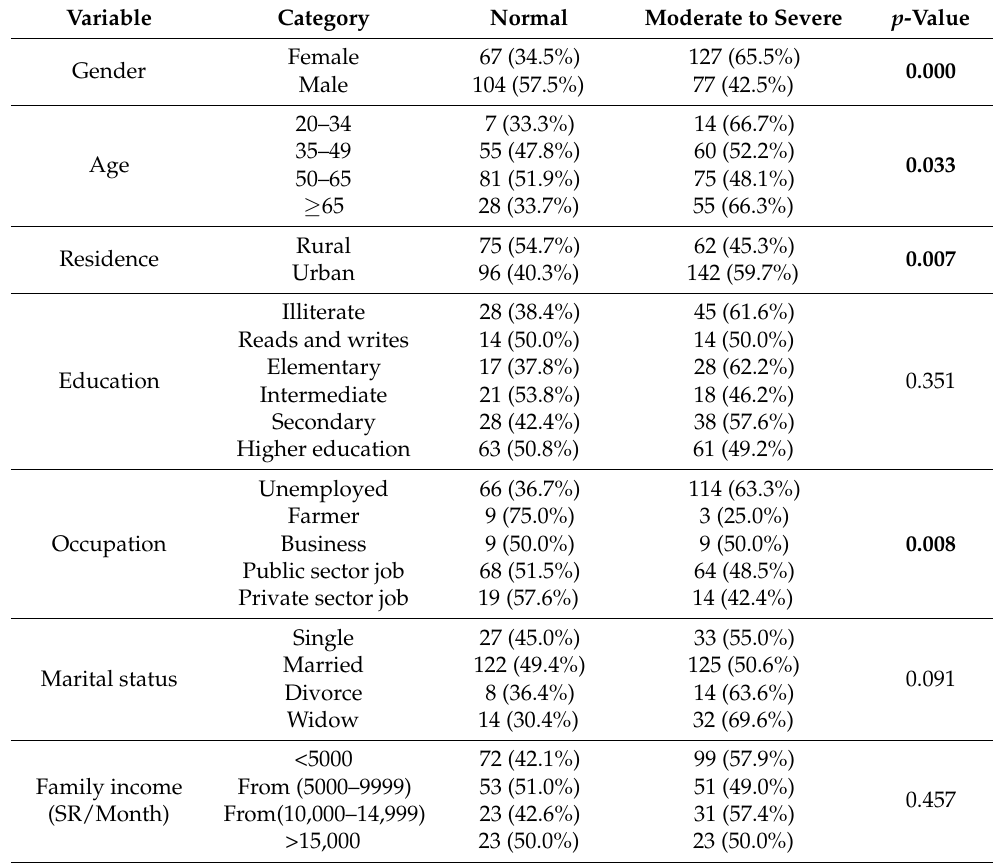
Table 2. Distribution of depression according to demographic characteristics of participants ( n =